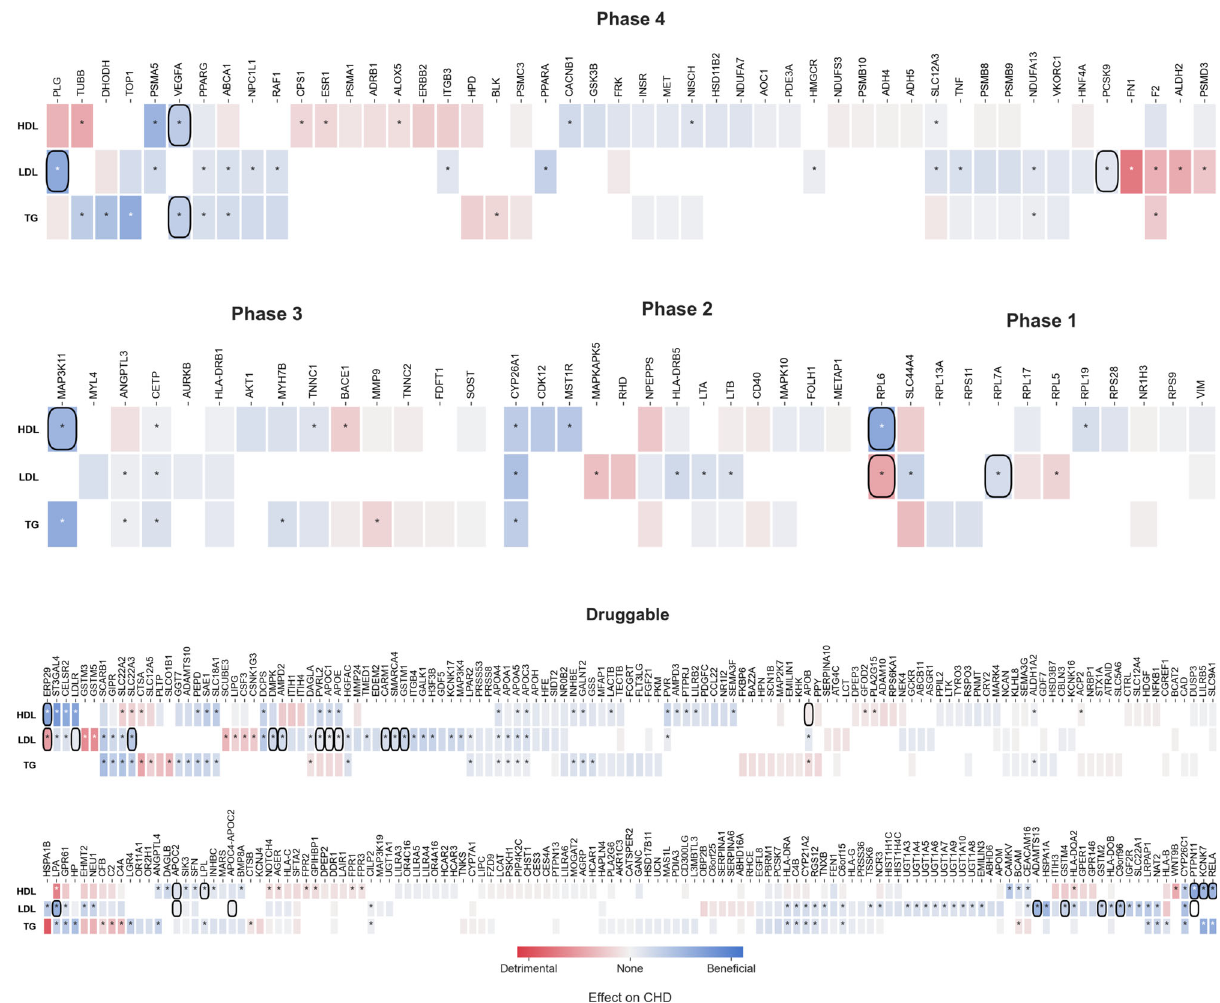
Fig. 2 Discovery drug target MR estimates on CHD. Analyses were performed using genetic associations with LDL-C, HDL-C, and TG from the Global Lipid Genetic Consortium (GLGC) with CHD events from the CardiogramPlusC4D Consortium. Drug targets are grouped by clinical phase according to the ChEMBL database. Blue indicates a bene fi cial effect on CHD risk and red a detrimental effect per SD difference with respect to the indicated lipid sub- fraction. Signi fi cant estimates are indicated with an asterisk (*). Co-localization of genetic effects on the relevant lipid sub-fraction and CHD at the same locus is indicated by a square around the